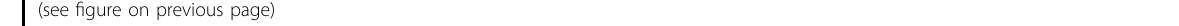
Fig. 1 HBO increases tumour volume but promotes chemosensitization. A Schematic process of the in vivo study with or without HBO treatment. B – D MRI showed that the tumour volume was larger and the tumour weight was higher in the group under HBO conditions than in the control group without HBO treatment in the absence of TMZ. However, after treatment with the same dose of TMZ (2 mg/kg), the tumour volume decreased and the tumour weight was decreased in the group exposed to HBO compared with the control group. E , F In the absence of TMZ, the survival time became shorter after HBO exposure (median survival time of the HBO treatment group vs control group = 22 vs 26 days). However, after TMZ treatment (2 mg/kg), the group that was exposed to HBO had a much longer survival time than the control group without HBO treatment (median survival of the HBO treatment group vs control group = 37 days vs 30.5 days). G The cells exposed to HBO had a higher proliferation rate than the control cells without HBO treatment in the absence of TMZ, but the cells exposed to HBO had a lower growth trend than the control cells without HBO following TMZ treatment (400 μ M). H The HBO treatment group had a higher apoptosis rate than the control group with the same TMZ treatment (400 μ M). The P value was determined by an independent samples t- test, and the survival time was analysed by the log-rank